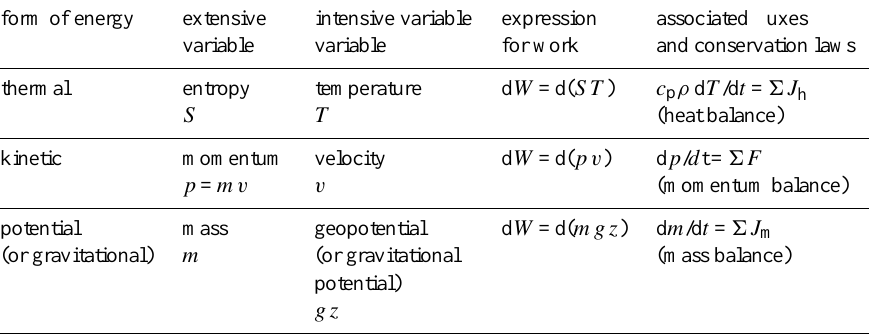
Table 1. Different forms of energy relevant for the description of drainage basin dynamics and their thermodynamic description as pairs of conjugate variables, one extensive variable that depends on the size of the system, and one intensive variable that is independent of the size of the